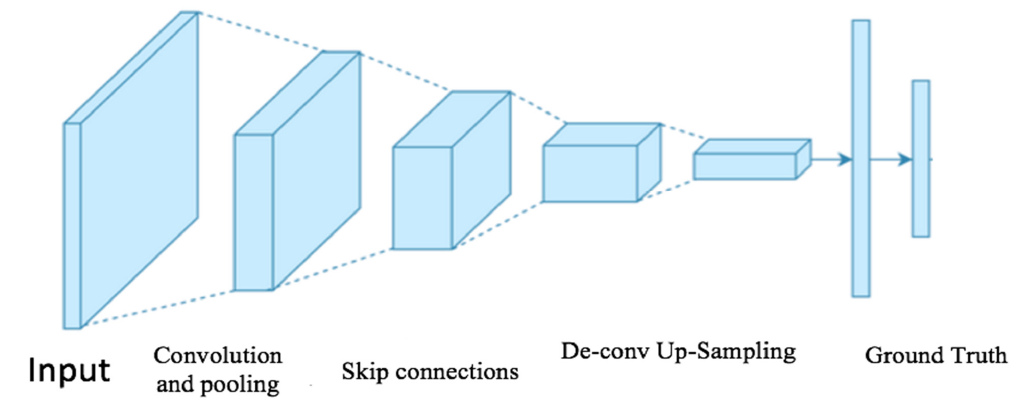
Figure 4. Structure of convolution neural network [31].